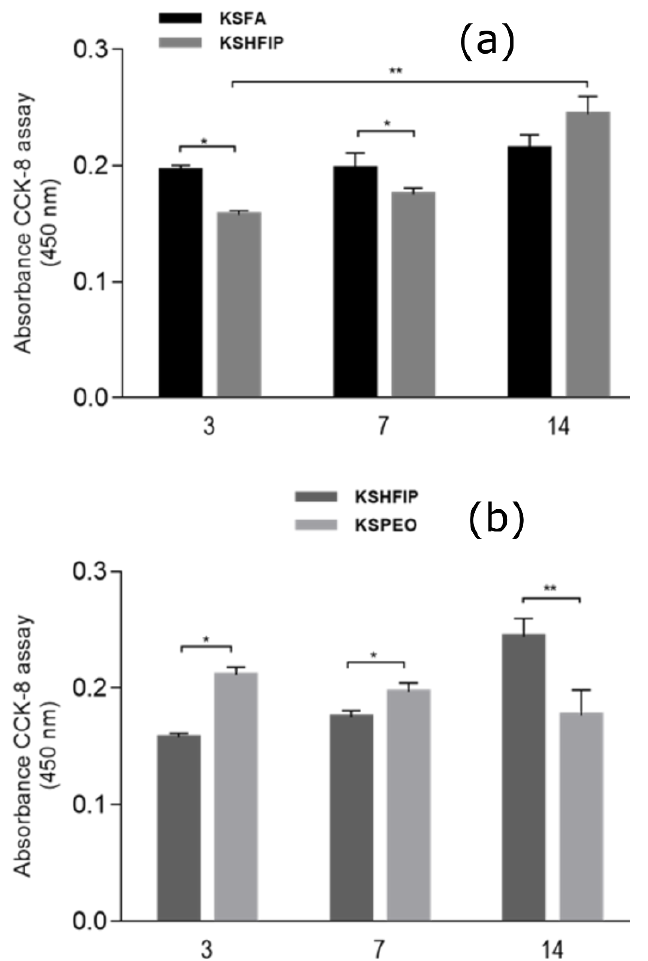
Figure 3. hMSCs viability cultured in KS-NFs from different solutions: ( a ) comparison of absorbance between KSFA and KSHFIP; and ( b ) KS with and without PEO. (*p<0.05, **p<0.01)